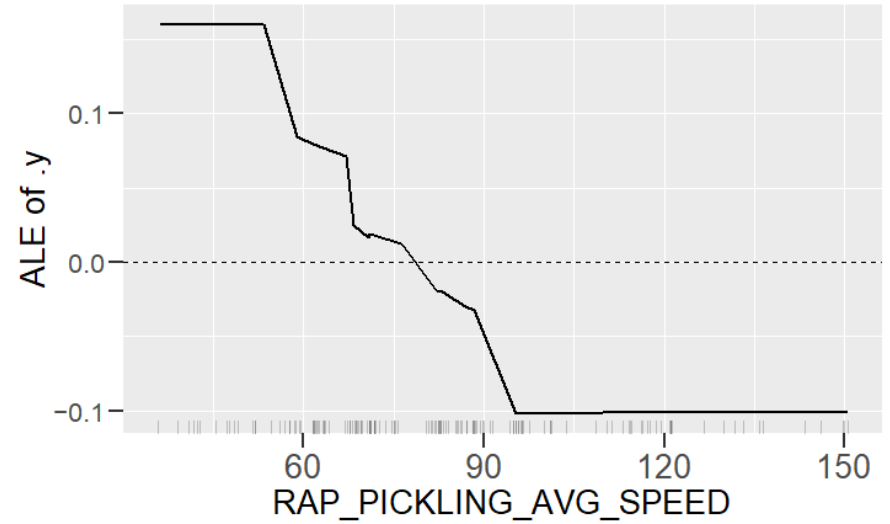
Figure 14. ALE of the average pickling speed to the predicted roughness of GBM (black solid line) on the Y -axis and the distributions of data points (black bars) on the X -axis.